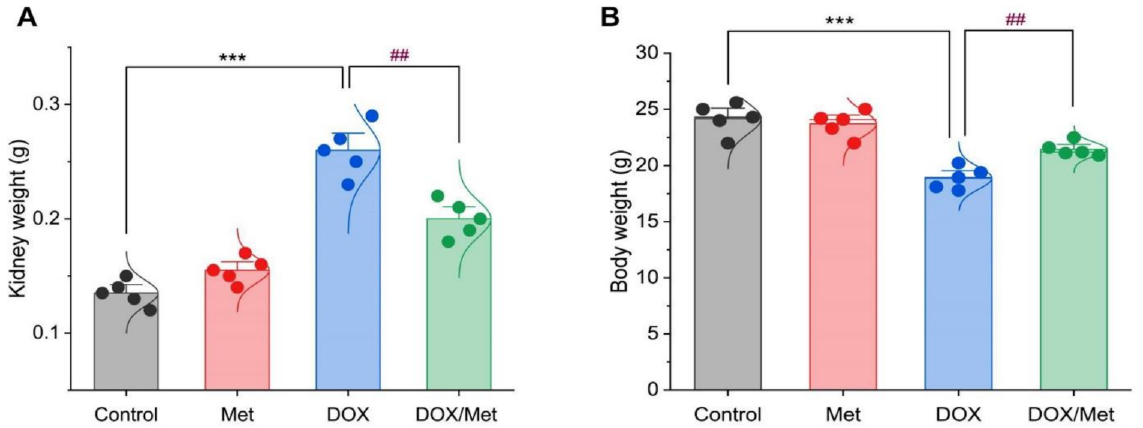
Figure 1. Bar-dot plot of the prophylactic effect of Met on the kidney and body weight changes induced by DOX-therapy. Prophylactic treatment with Met for 3 weeks decreased both kidney weight ( A ) and body weight ( B ) in comparison with the DOX group. Student’s t -test was used for statistical comparisons. Data are expressed as mean ± SEM. Colored dots indicate each individual value and colored curves represent the distribution of each data point. *** p < 0.001 vs. control group and ## p < 0.01 vs. DOX